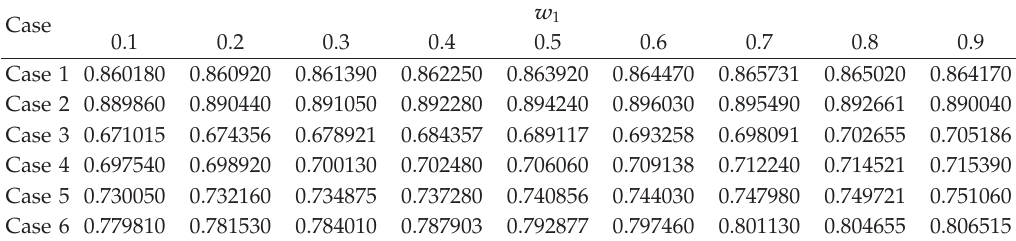
Table 2: Comparison of the optimal